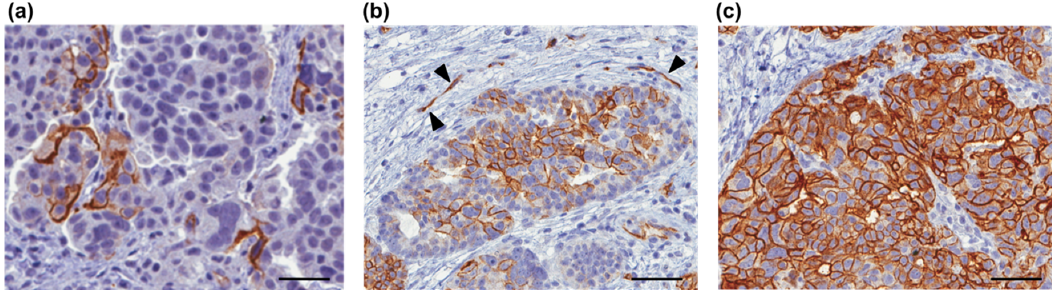
Figure 3. L1CAM levels in ovarian cancer. Three examples of high-grade serous ovarian cancer with different levels of L1CAM are shown. L1CAM is visualized by immunohistochemistry on formalin-fixed paraffin-embedded specimens. The protein is localized on the cancer cell membrane with levels that range from (a) a minority of cells to (c) most of the tumor mass. The arrowheads in (b) show ovarian cancer-associated vessels that are L1CAM-positive as previously described [56]. Scale bars: (a), 25 µm; (b,c) 50 µm.